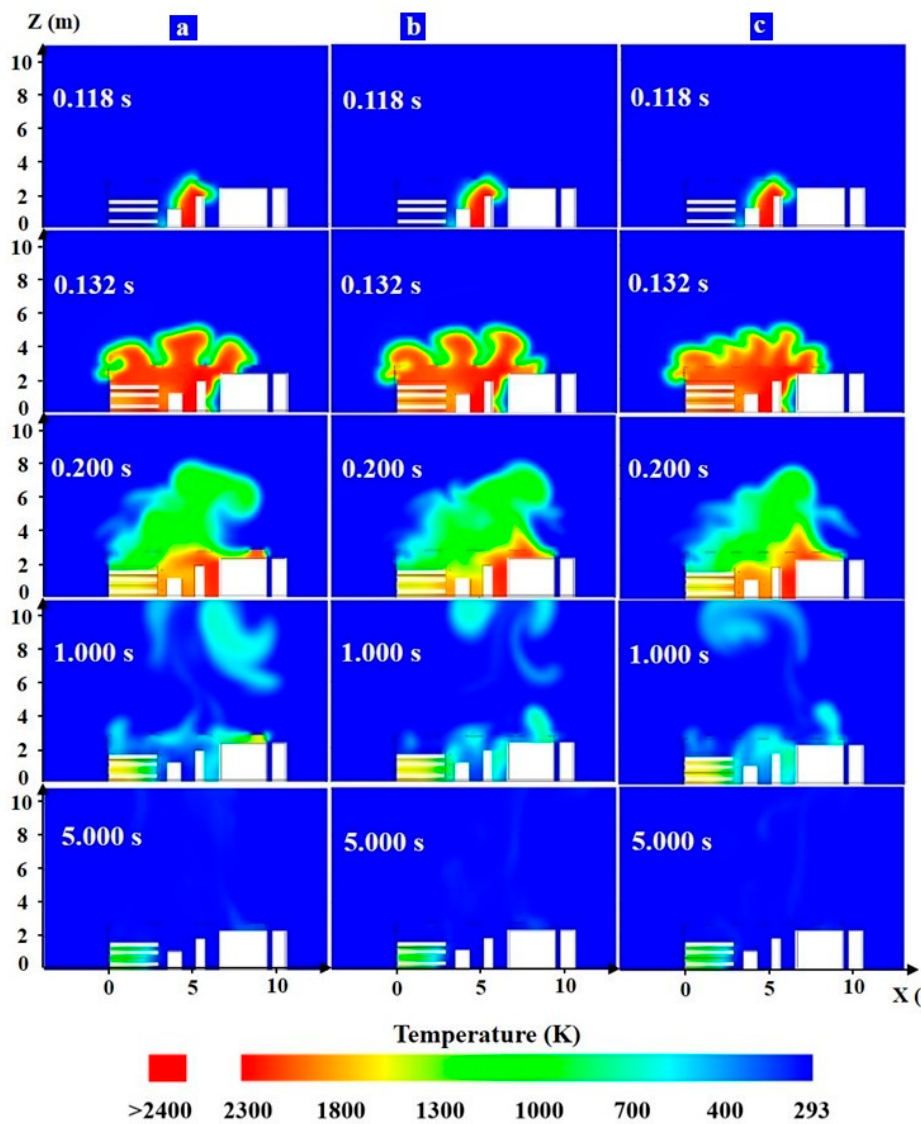
Figure 6. Temperatures at various times for various explosion vent layouts ( a – c